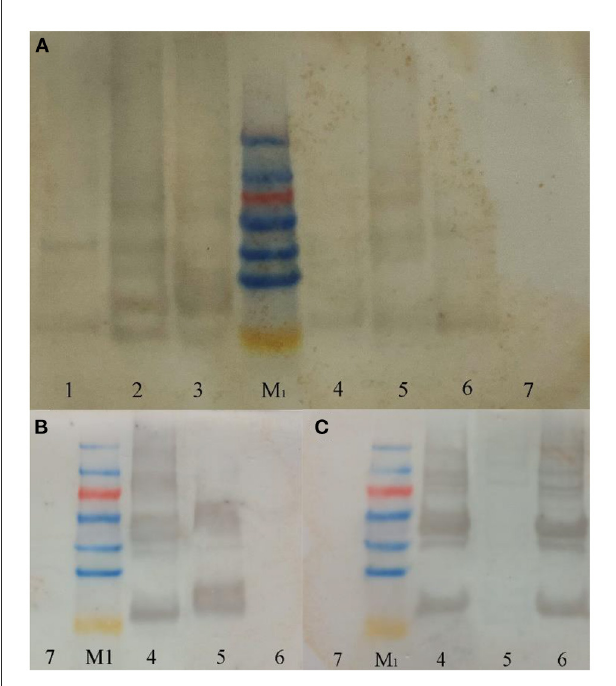
FIGURE3 Western blot results. (A) Western-blot with Anti-6 × His Tag mouse monoclonal antibody; (B) western-blot with PC antibody; (C) western-blot with APC antibody. Lane1, Purified sample of target protein from strain E. coli PC; Lane2, Purified sample of target protein from strain E. coli APC; Lane3, Purified sample of target protein from strain E. coli PC-APC; Lane4, Purified sample of target protein from strain E. coli PC-APC-HPUSTEF Protein purification sample; Lane5, Purified sample of target protein from strain E. coli PC-HPUSTEF; Lane6, Purified sample of target protein from strain E. coli APC-HPUSTEF; Lane7, Unpurified protein sample of control E. coli BL21; Lane M 1 , SDS-PAGE Protein